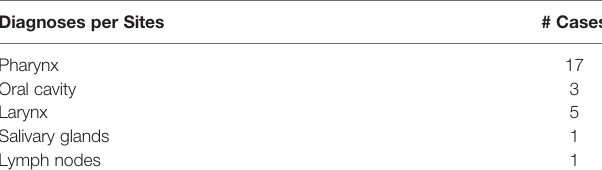
TABLE 1 | Distribution of HNC sites from the patient cohort.